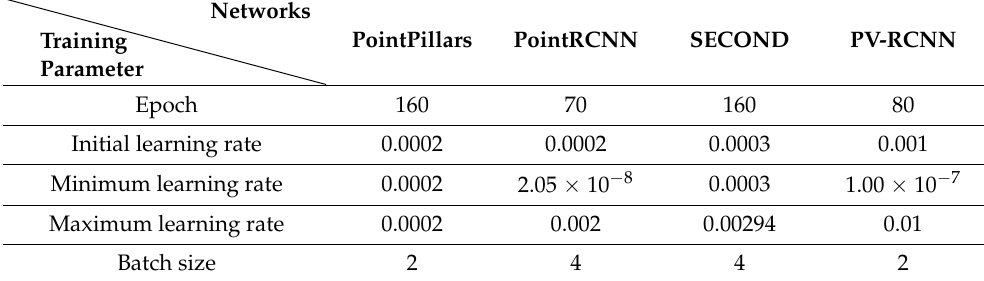
Table 2. Hyperparameter setting for four networks.